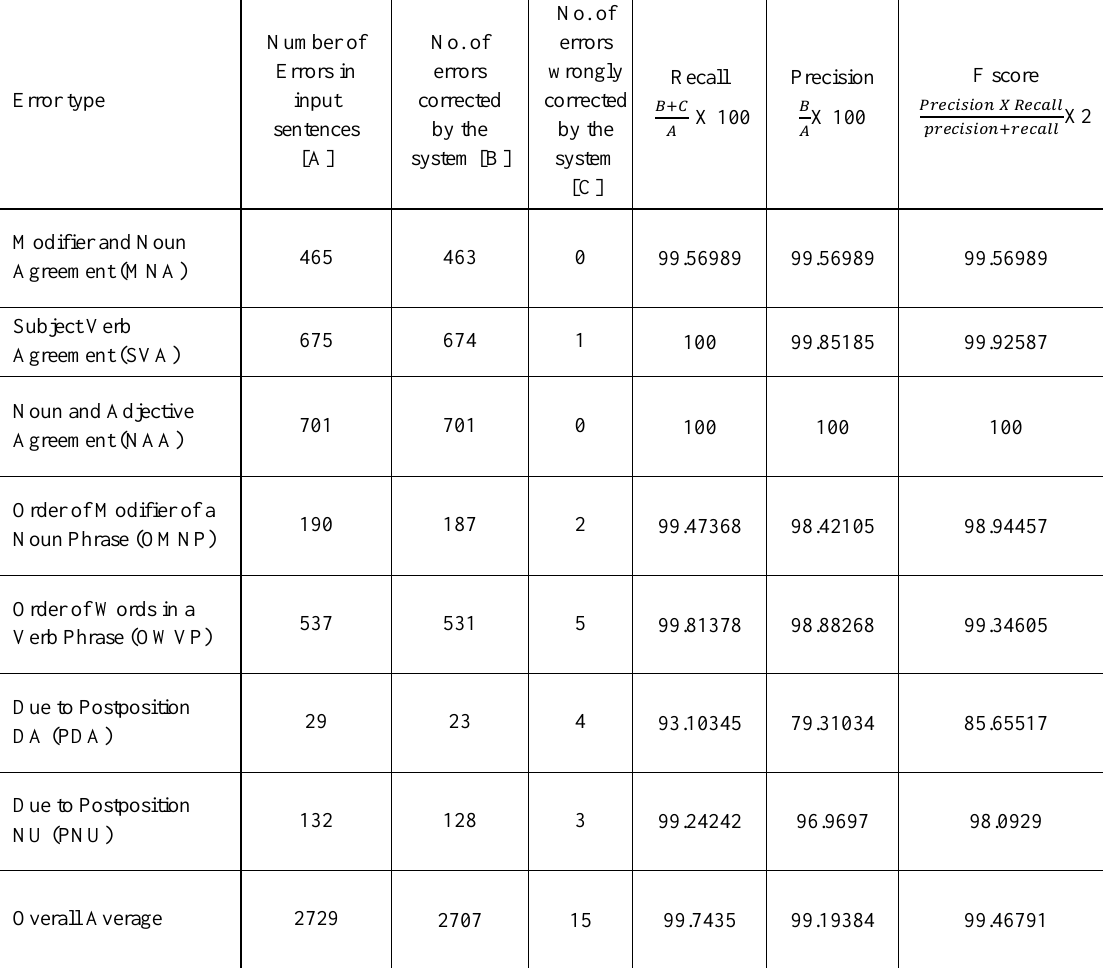
Table 3.1: Experimental evaluation of grammar checking of compound sentences (Dummy test data)